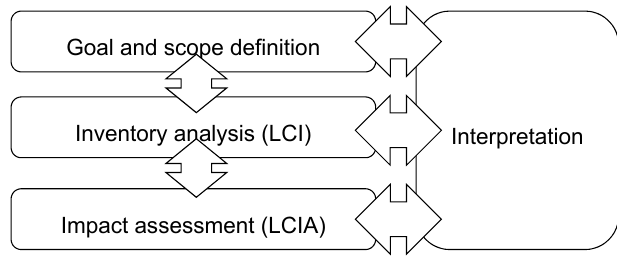
Figure 3. Life cycle assessment (LCA) framework [18].